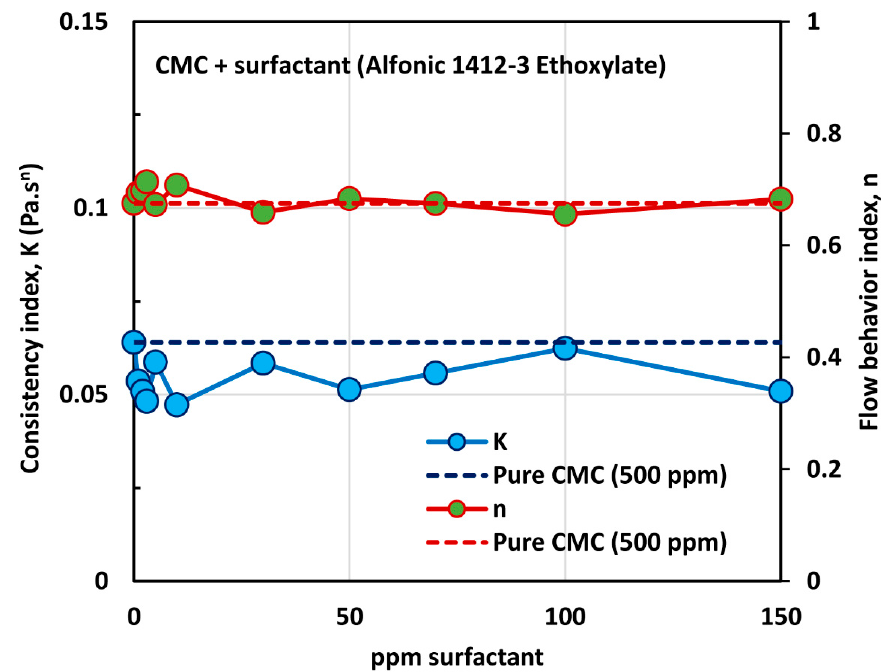
Figure 12. Variations of consistency index, K , and flow behavior index, n , for mixtures of anionic polymer, CMC, and non-ionic surfactant, Alfonic 1412-3 Ethoxylate, with the increase in surfactant concentration, at a fixed polymer concentration of 500 ppm.